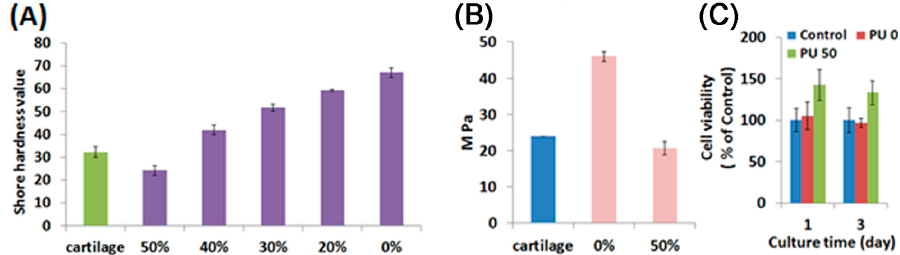
Figure 2. The physical properties and cell viability of water-based polyurethane (PU) based photosensitive materials with different proportions of the water-based thermoplastic polyurethane. ( A ) Shore hardness values and ( B ) Young’s modulus of the water-based polyurethane based composites compared with articular cartilage; ( C ) Cell viability of hWJMSCs cultured on the water-based polyurethane based composites with 0% or 50% of the water-based thermoplastic polyurethane for 1 and 3 days. Values in ( A – C ) represent mean and SD ( n = 3).